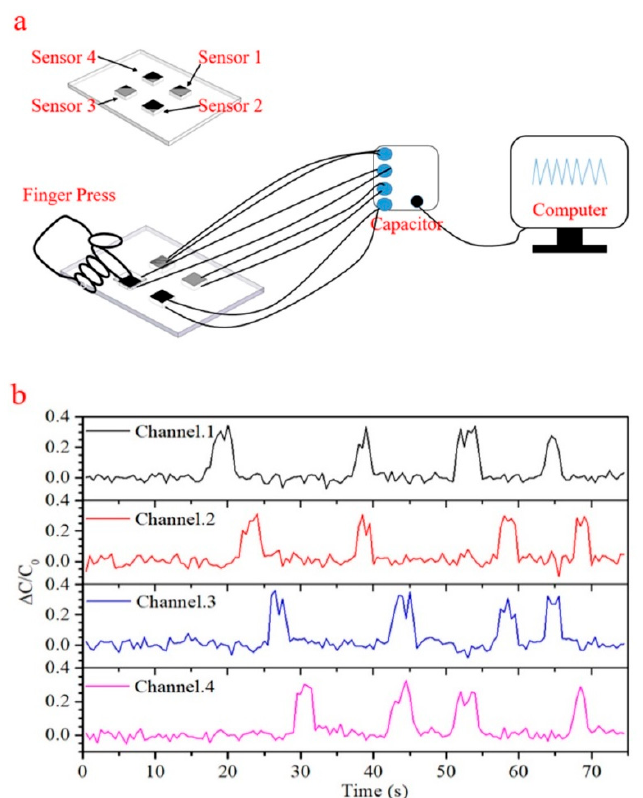
Figure 7. ( a ) The test circuit diagram of a four channel pressure sensing mat. ( b ) Capacitive traces demonstrating channel separation and signal multiplexing.